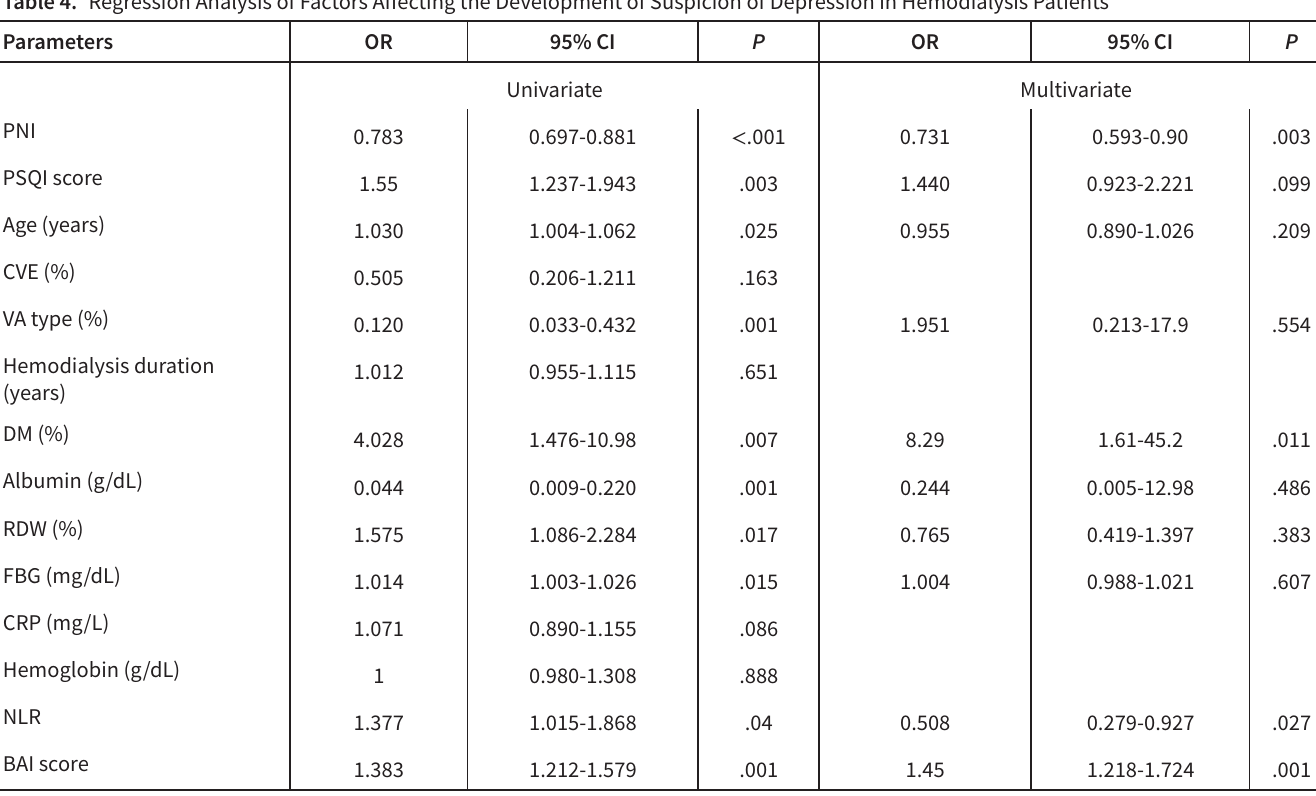
Table 4. Regression Analysis of Factors Affecting the Development of Suspicion of Depression in Hemodialysis Patients